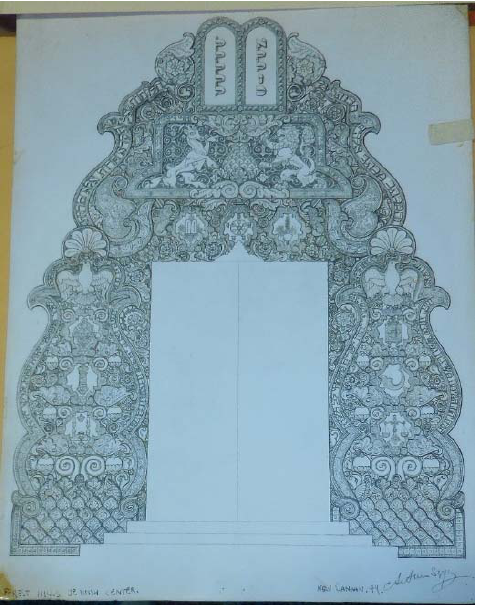
Figure 3. Arthur Szyk, ink sketch for the sides of the ark, 1949.